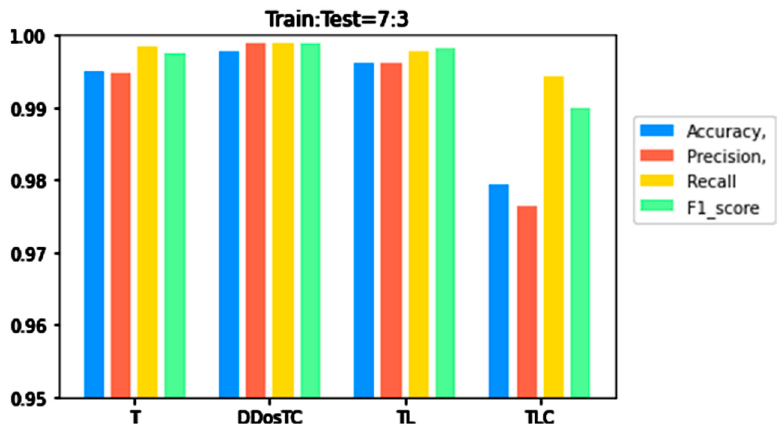
Figure 6. A performance comparison of DDosTC and transformer, tranformer + CNN + LSTM, and transformer + LSTM (Train/Test = 8:2).